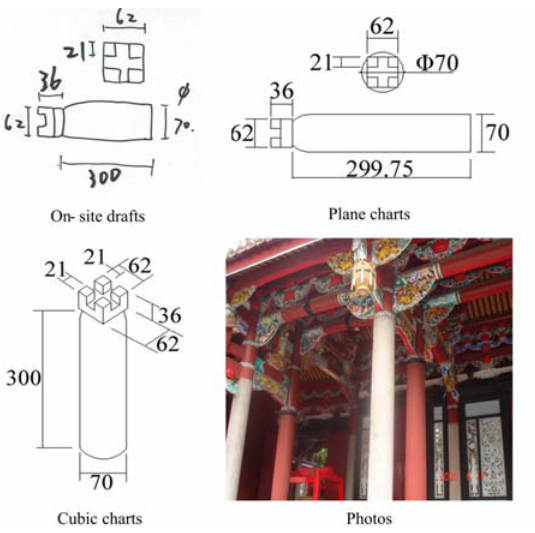
Fig. 3. Drawings of timber components in